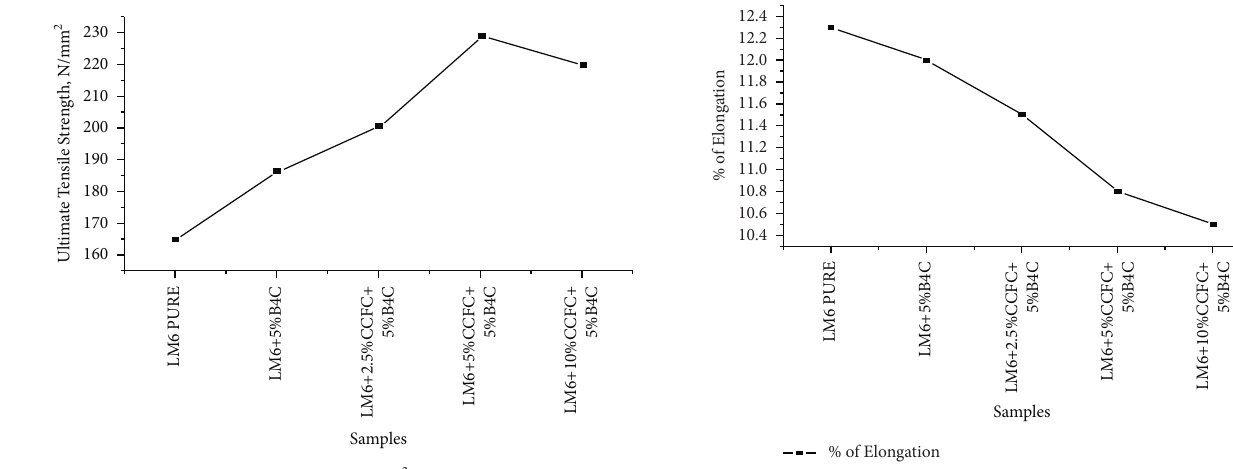
Figure 9: Percentage of elongation of LM6 Al alloy hybrid